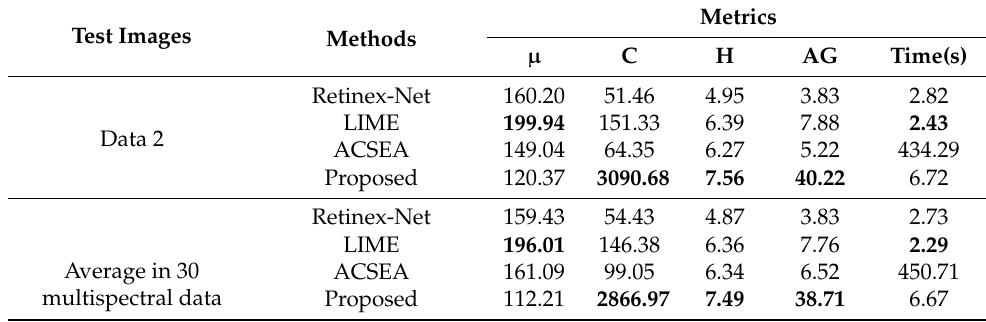
Table 7. The quantitative results of the four image enhancement